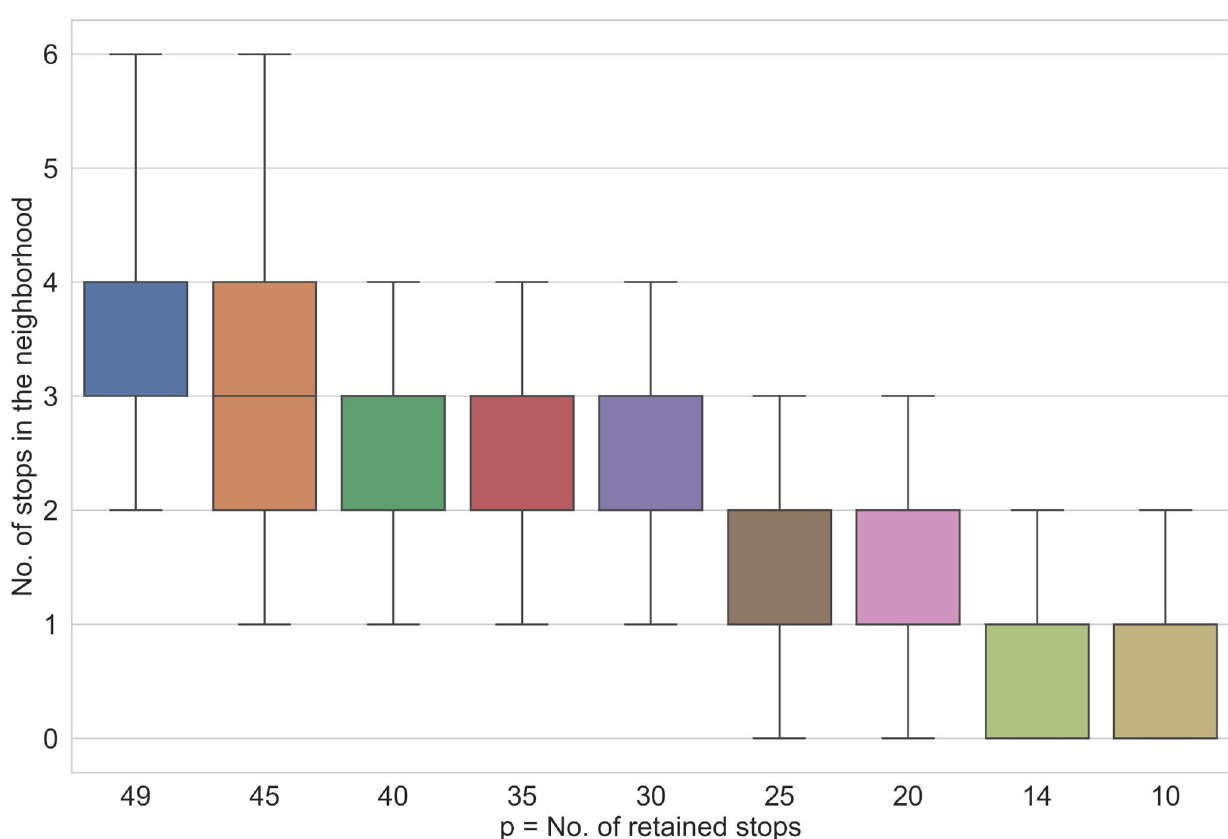
Fig 9. Min, max and a median number of stops in dissemination area neighbourhoods for different values of p